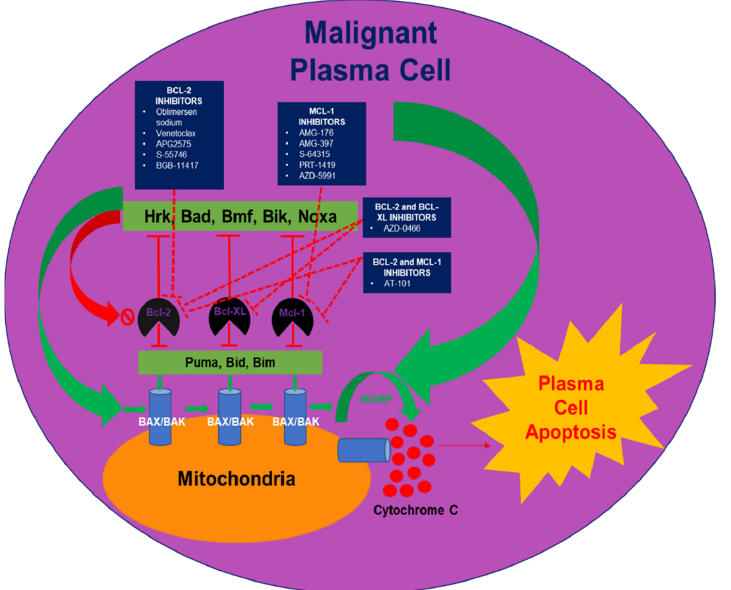
Figure 1. Bcl-2 family protein interactions and drug targeting inhibition of anti-apoptotic Bcl-2 family proteins. Pro-apoptotic BH3 only sensitizer proteins Hrk, Bad, Bmf, Bik, and Noxa selectively bind to and inhibit the anti-apoptotic Bcl-2 family members Bcl-2, Bcl-XL, Mcl-1 (and other proteins not depicted here). Anti-apoptotic Bcl-2 family proteins sequester BH3 only apoptotic activator proteins Puma, Bid, and Bim. Free BH3 only apoptotic activator proteins induce the oligomerization of apoptotic effectors BAK and BAX at the mitochondrial membrane which in turn cause mitochondrial outer membrane permeabilization (MOMP) and the release of cytochrome C into the cytosol ultimately resulting in plasma cell apoptosis. Oblimersen sodium, venetoclax, APG2575, S-55746 and BGB-11417 inhibit Bcl-2. AMG-176, AMG-397, S-64315, PRT-1419, and AZD-5991 are Mcl-1 inhibitors. AZD-0466 inhibits both Bcl-2 and Bcl-xL. AT-101 inhibits Bcl-2 and